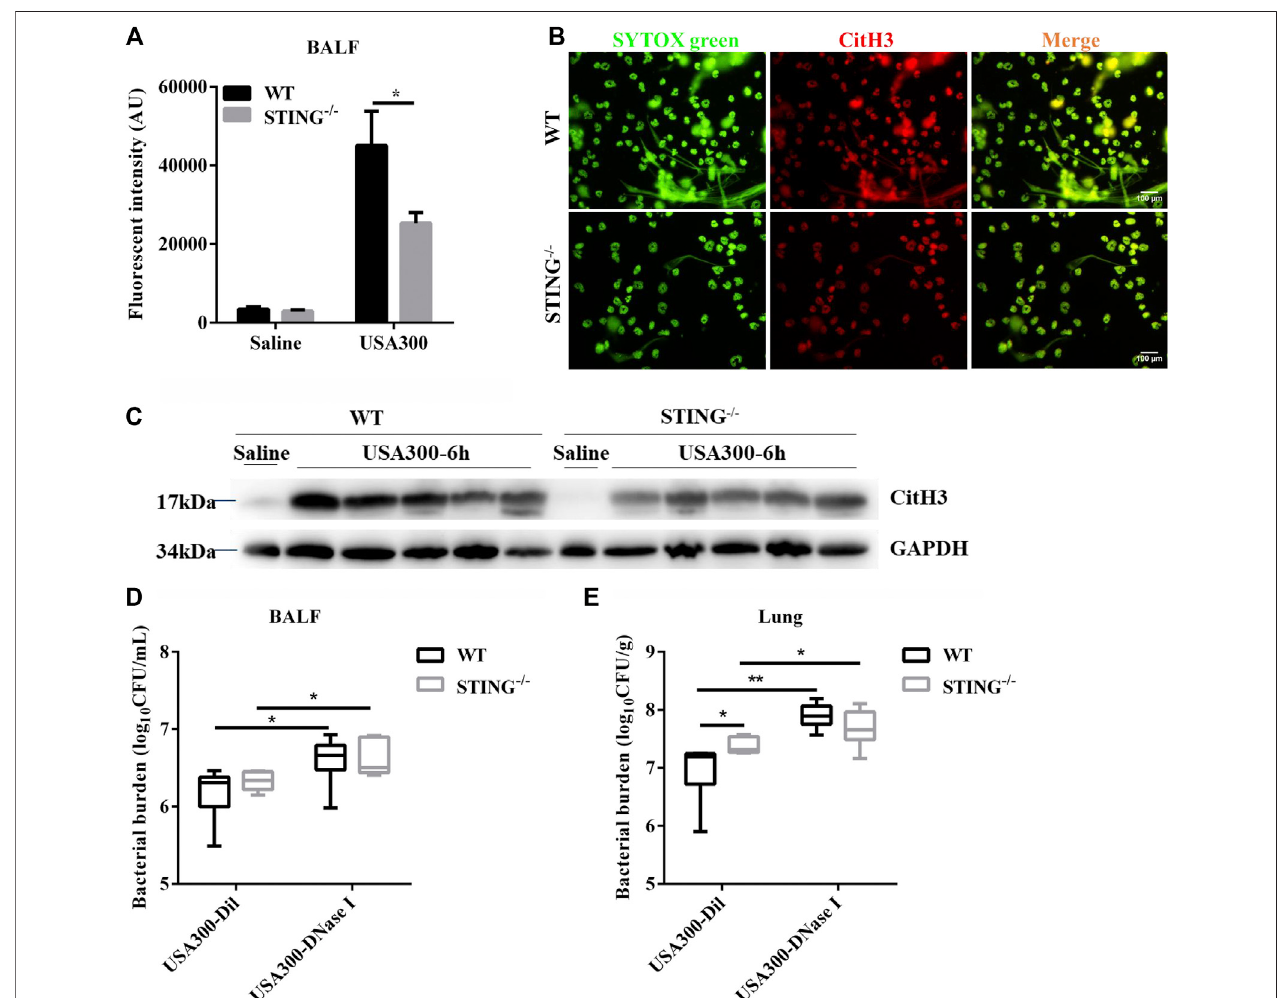
FIGURE 7 | STING -/ − mice display decreased ETs production and reduced bactericidal ability during S. aureus pulmonary infection. WT and STING -/- mice (n = 4 – 7/group)wereinfectedwith S.aureus (1×10 8 CFU/mouse, i.t. )andsampleswerecollectedat6hpi. (A) cfDNAinBALFwasquanti fi ed. (B) CellsofBALFwere fi xed ex vivo , DNA decorated with CitH3 was detected using a fl uorescence microscope. DNA was stained with SYTOX green. (C) The lung tissue lysate was detected for the expression ofCitH3andGAPDH.WTandSTING -/- micewerechallengedwith S.aureus (1×10 8 CFU/mouse, i.t. )andtreatedwithDNaseI(4000U, i.t. )ordiluent control at 2 hpi (n = 6 – 7/group) and then were euthanized at 6 hpi. (D) bacterial counts in BALF and (E) bacterial counts in lungs were quanti fi ed. All data are shown as mean ±SEM. Datapooled from 2 independent experiments. Data were analyzed using two-way ANOVA withBonferroni ’ s multiple comparison test. For all experiments in this fi gure: * p < 0.05, ** p <